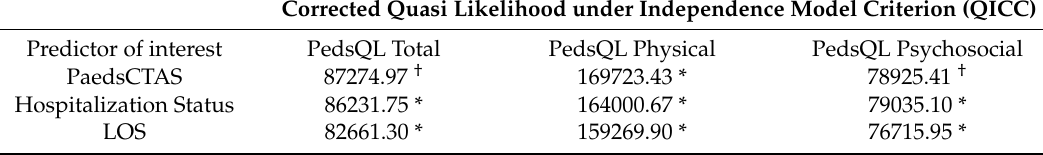
Table 4. Generalized estimating equations of quality of life following an